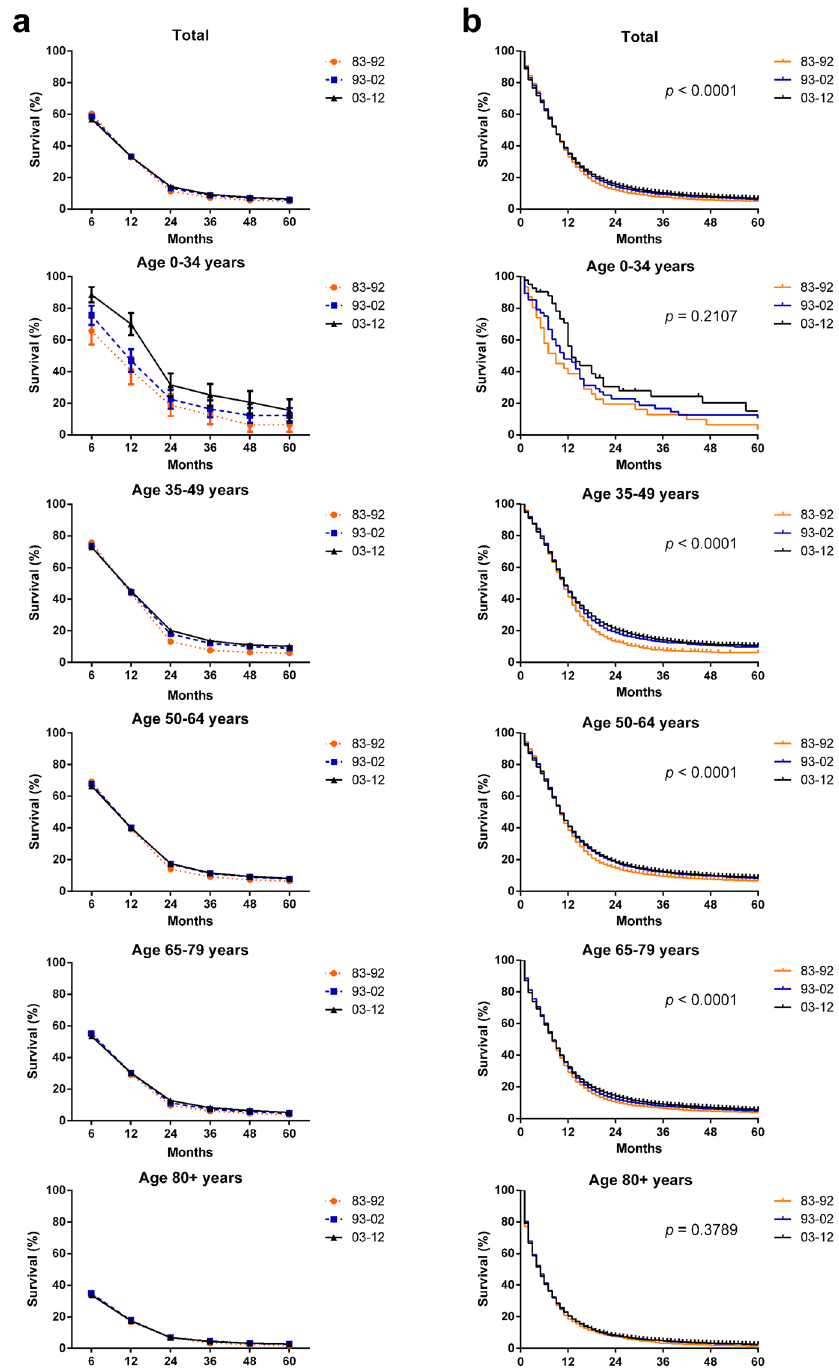
Figure 2. Trends in five-year relative survival rates ( a ) and Kaplan-Meier survival analyses ( b ) for patients with SCLC at 18 SEER sites between 1983 and 2012 according to age group (total and ages 0–34, 35–49, 50–64, 65–79, and 80 + years) and calendar